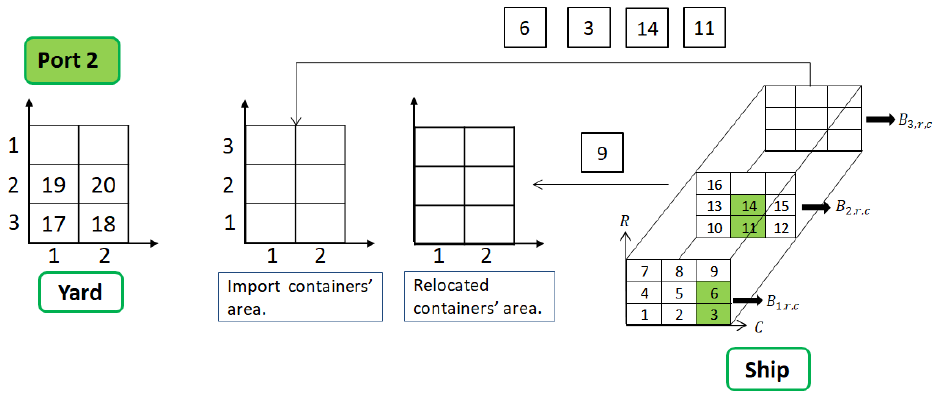
Figure 2. Unloading flow at port